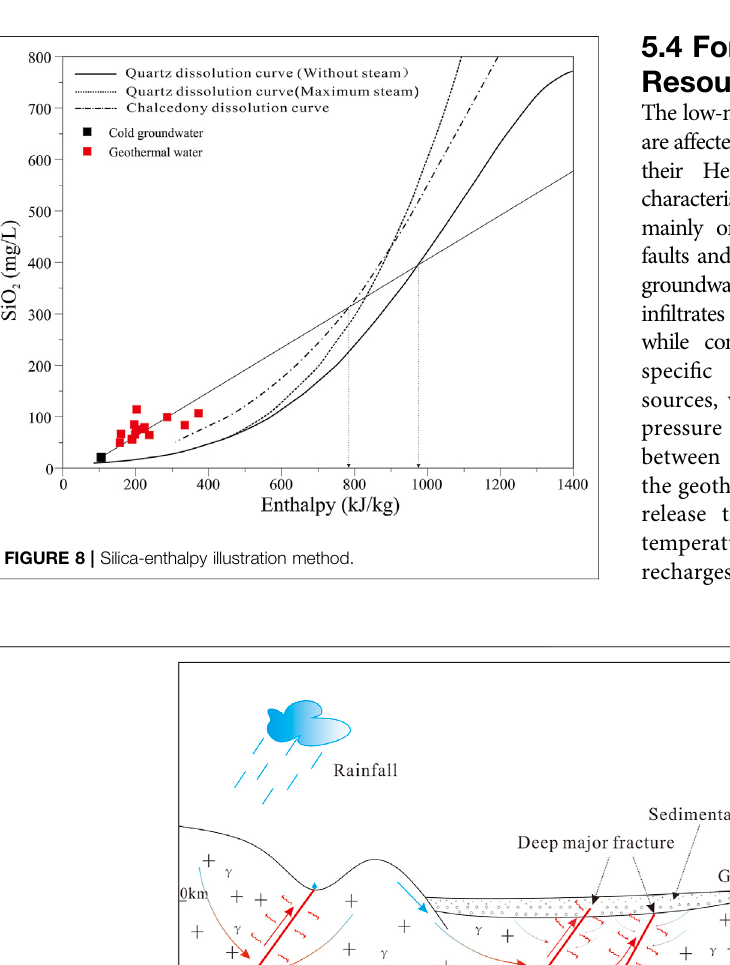
Frontiers in Earth Science |